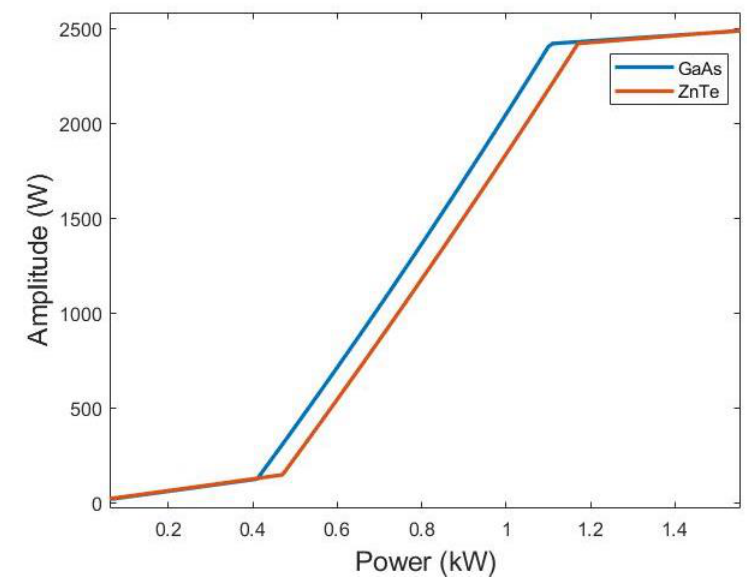
Figure 8. The power responsivity for the electro-optic